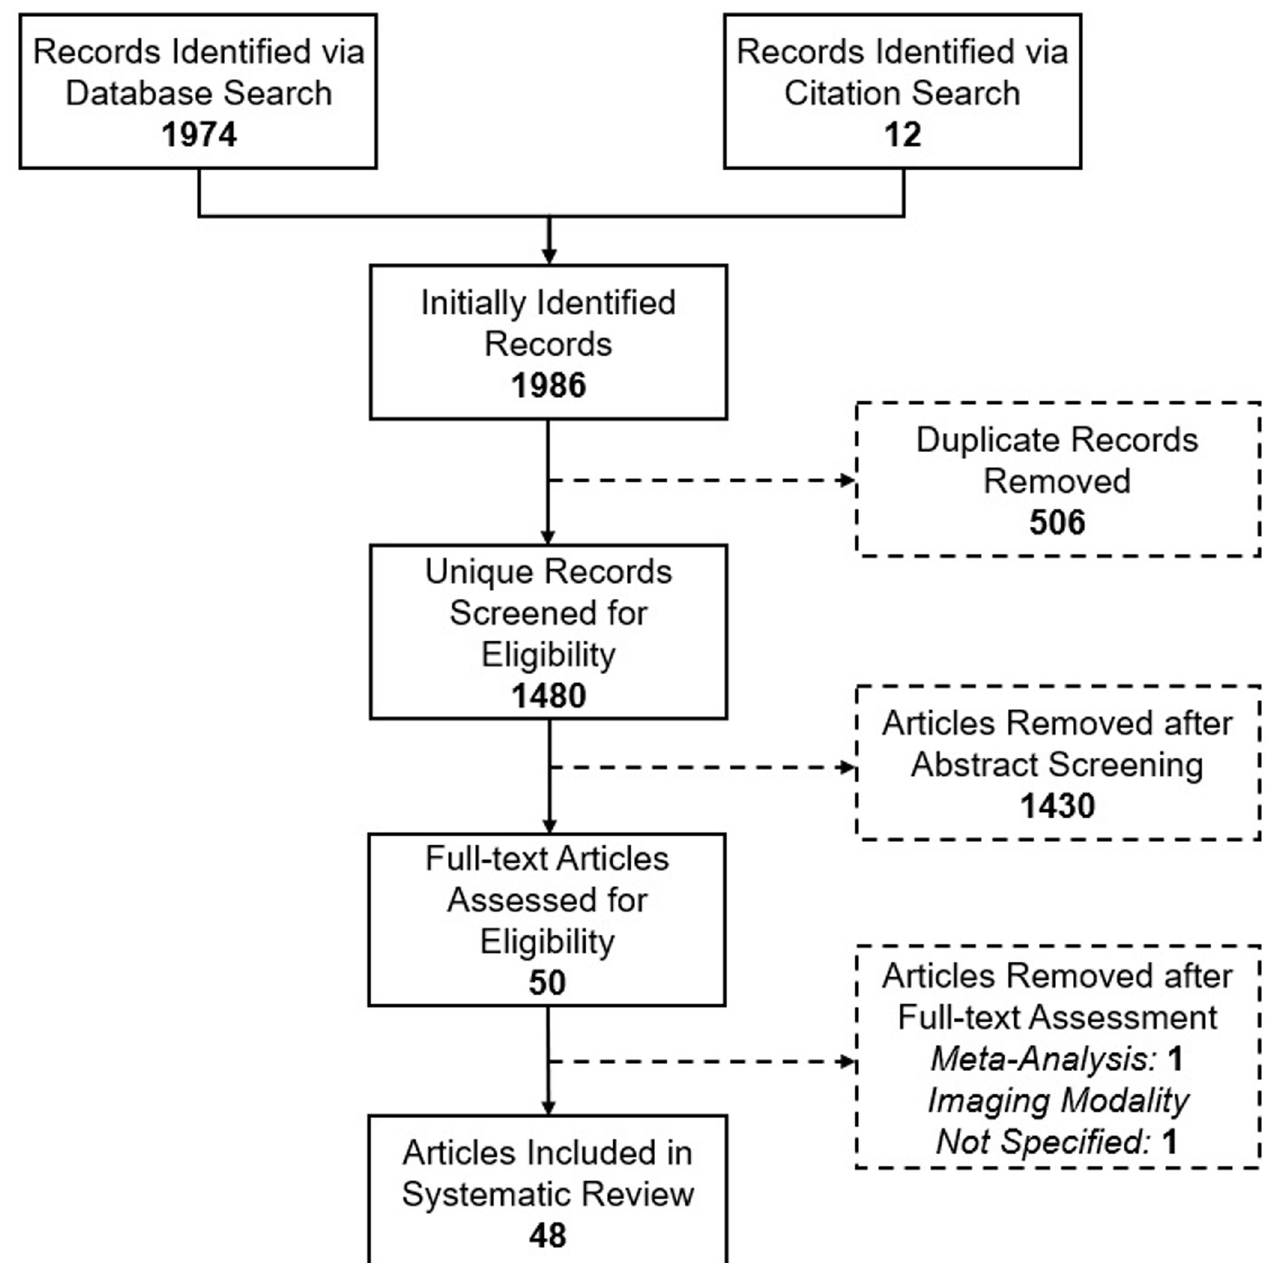
Fig 1. Search strategy flow